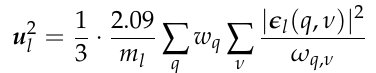
√ 2 √ 2 in intensity. The scaling